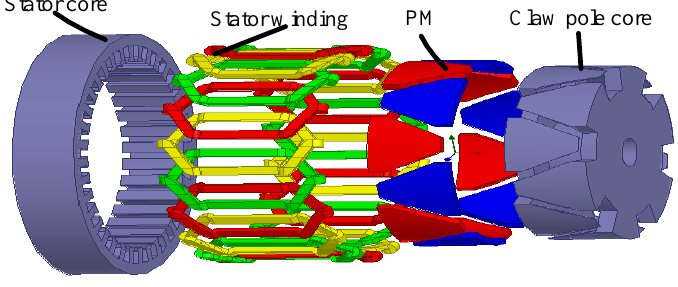
Figure 1. 3D model of the motor.